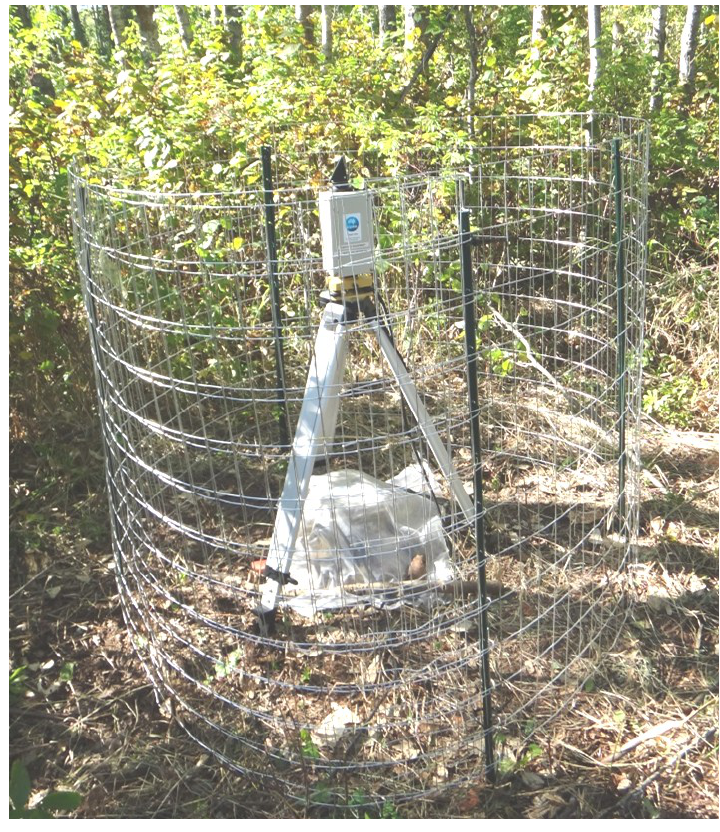
Figure 1. The VEGNET In-Situ Monitoring Lidar (IML) system deployed in the Aspen forest parkland study site, southeast Edmonton, AB, Canada; the rotating prism system directs the laser at 57.5° zenith; The instrument was protected from large animals using aluminum fencing